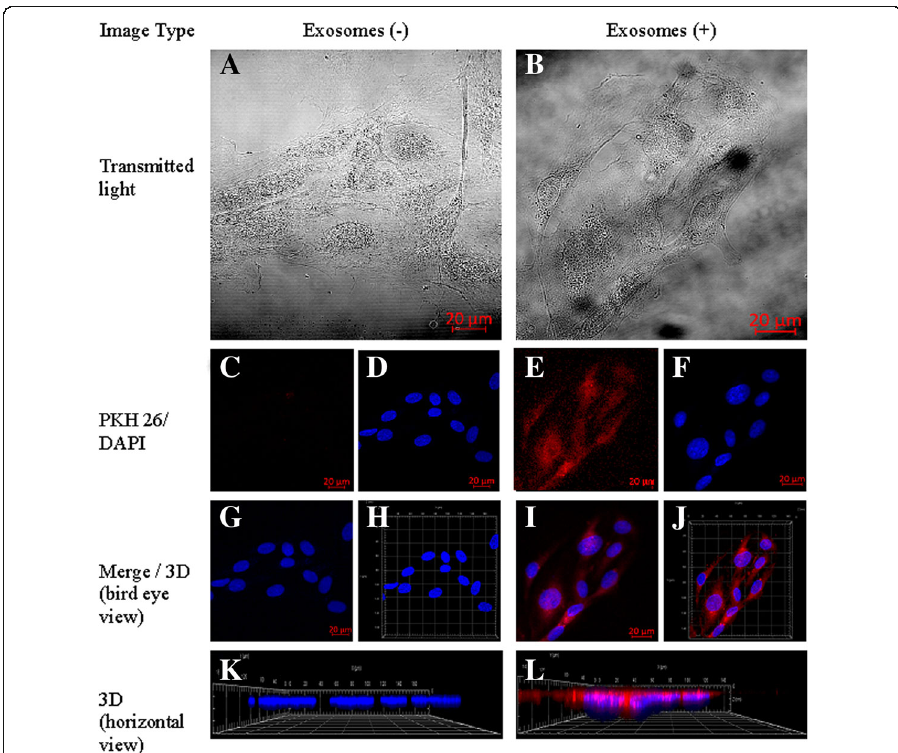
Fig. 3 Cellular internalization of HUVEC-derived EVs into HUVECs. HUVECs were incubated for 24 h with EVs labelled with PKH26 (red). The carryover of PKH26 was observed when cells were incubated with PKH26 without EVs (negative control). a , b – Transmitted light. c , e – PKH26 staining. d , f – DAPI staining. g , i – Merged 2D view. h , j – Merged 3D view. k , l – 3D horizontal